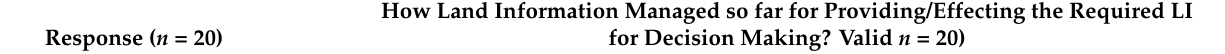
Table 6. Responses of LI experts on the availability of LIMS.